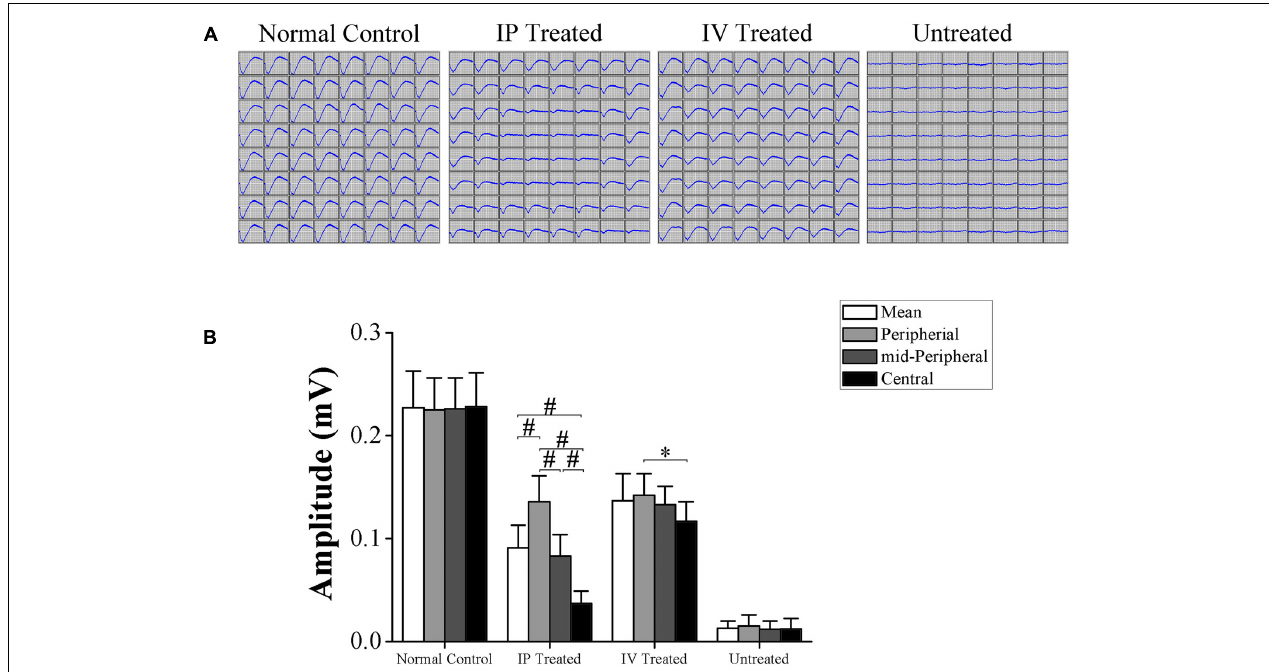
FIGURE 2 | Topographic effects of HRS treatment on the field potentials of MNU administered rats. (A) Representative field potential waveforms of the examined eyes. The field potentials of the untreated group were substantially ruined by MNU administration and no consolidated waveform was found; conversely, the field potential waveforms of the IV and IP treated group were preserved efficiently. (B) The mean amplitudes of field potentials in the untreated group was remarkably smaller than normal controls ( P < 0.01). The mean amplitude of field potentials in the IV and IP treated group were significantly larger than the untreated group ( P < 0.01). The mean amplitude of field potentials in the IP treated group was smaller than the IV treated group ( P < 0.05). The field potentials in peripheral region of IP treated group retained larger amplitudes than the central and mid-peripheral region ( P < 0.01); the mean amplitude of field potentials in the mid-peripheral region was significantly smaller than the peripheral region ( P < 0.01). The field potential responses in IV treated group were much more uniformly distributed, except for the mean amplitude in the central region was slightly smaller than the peripheral region ( P < 0.05) (All the values were presented as mean ± SD; ∗ P < 0.05, # P < 0.01 for differences compared between the animal